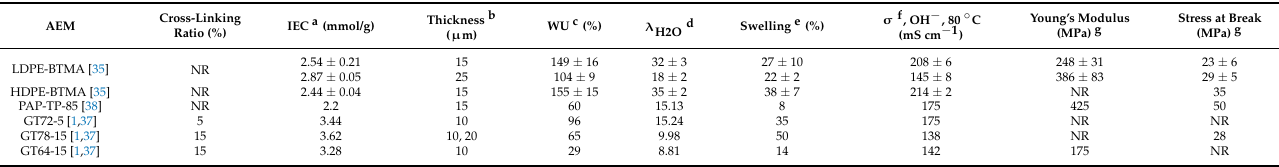
a IEC = mmol Cl − per g (dry AEM, Cl − form). b Dehydrated AEM thickness at room temperature (Cl − form). c Gravimetric water uptake (Cl − form) at room temperature (= 100 × ( m hyd − m dehyd )/ m dehyd , where m = mass/g). d The number of water molecules per Cl − anion in the fully hydrated AEM, calculated as: λ H2O = WU/(100 × 18.02 × IEC). e Through-plane swelling (= 100 × ( t hyd − t dehyd )/ t dehyd ). f The 4-probe (in-plane) OH − conductivity in a flowing 100% relative humidity N 2 atmosphere. g Tensile properties of the Cl − -form AEMs (error within 25%) in the ambient atmosphere. NR = not